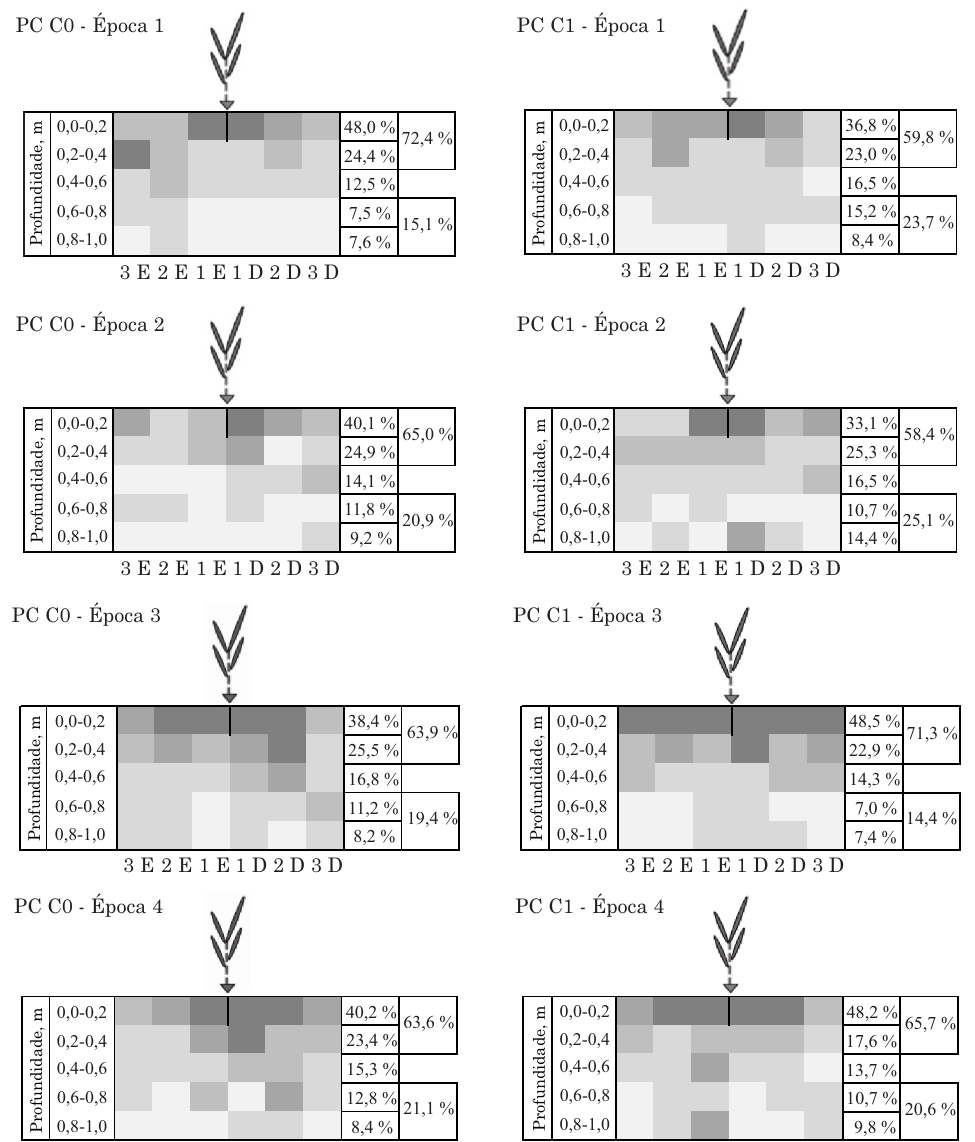
Figura 4. Distribuição do sistema radicular no plantio convencional (PC), por camada de solo, nas quatro épocas de amostragem: 1 - máximo deficit hídrico, 2 - início reposição hídrica, 3 - máximo excedente hídrico e 4 - início déficit hídrico, sem calcário (C0) e com 2,0 t ha -1 de calcário (C1) em seis posições: 1D - rente ao lado direito da soqueira; 2D - 30 cm à direita da posição 1D; 3D - 30 cm à direita da posição 2D; 1E - rente ao lado esquerdo da soqueira; 2E - 30 cm à esquerda da posição 1E; e 3E - 30 cm à esquerda da posição local no solo pode proporcionar maior crescimento de